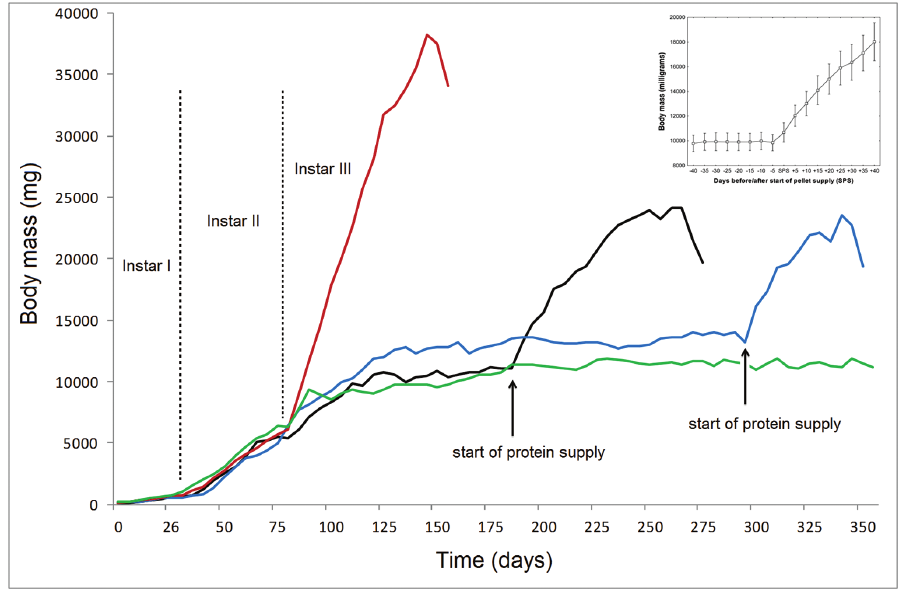
Figure 4. Individual growth trajectories of the fully nourished larva (red line), partly nourished larvae (black and blue lines) and undernourished larva (green line). Evidently, the absence of proteins in larval diet had profound consequences on development. In the third instar, the starved larvae were able to re- sume growth immediately after the addition of protein to their diet. The inset image shows mean growth of all eleven partly nourished larvae 40 days before and after pellet supply (SPS), irrespective of actual time of pellet supply. Means ± standard errors are